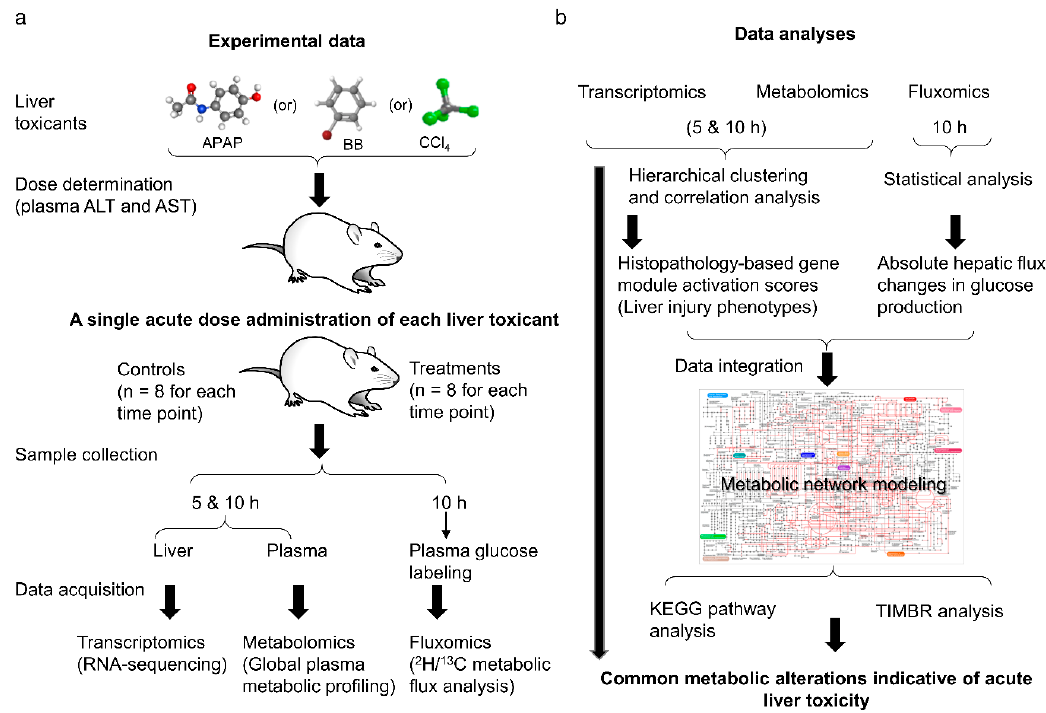
Figure 1. A schematic diagram showing the summary of experimental data generation and computational analyses. ( a ) Experimental study design to capture early perturbations in liver metabolism using transcriptomics, metabolomics, and fluxomics. ( b ) Global analysis of omics data to identify commonalities in liver response to toxicant exposure and data integration using genome- scale metabolic models to identify common metabolic signatures indicative of liver toxicity.